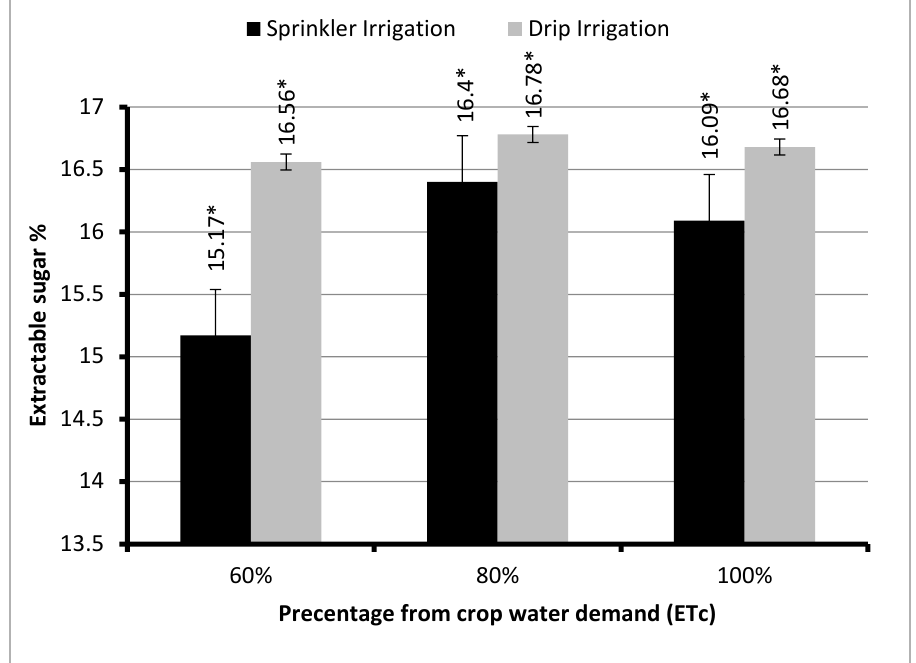
Figure 6. Date palm’s extractable sugar (%) under drip and sprinkler irrigation systems with different regimes. Significant differences *, Non-significant **, (ha): Hectare, WP: Water produc- tivity, M 3 : Quebec meter.